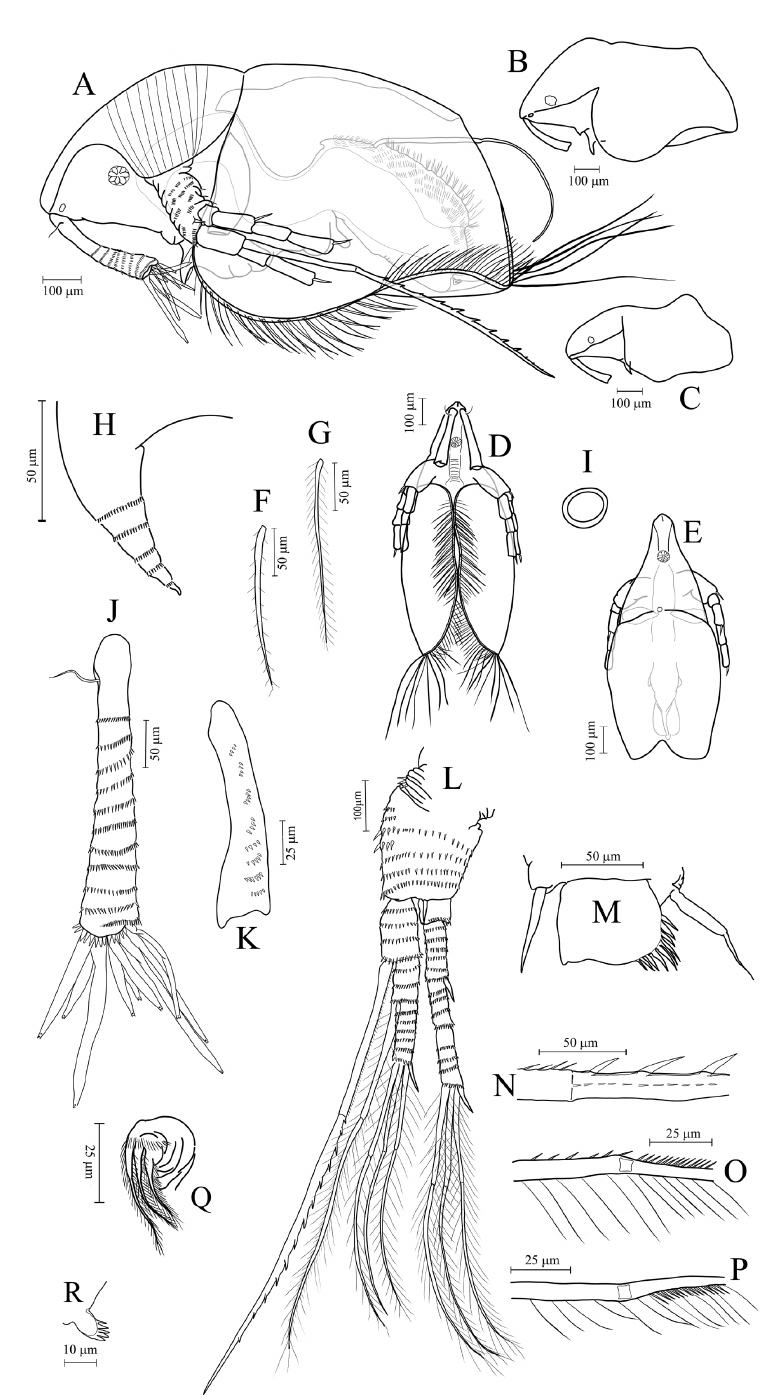
Fig. 2. Acantholeberis accolismaris Sousa, Elmoor-Loureiro & Álvarez-Silva sp. nov., parthenogenetic female from the Planície Costeira, Rio Grande do Sul (FDRS0696). A . Habitus, holotype. B–C . Lateral view, shape variation of carapace. D . Ventral view. E . Dorsal view. F . Outwardly directed setae. G . Plumose and ventrally directed setae. H . Horn-like outgrowth anterior to labrum. I . Dorsal organ. J . Antennule. K . Idem, inner surface. L . Antenna. M . Idem, first segment of exopodite, distal outer spine and inner sensory seta on basal segment. N . Idem, lateral seta of first segment of endopodite, armature detail. O–P . Morphology of apical setae of endopodite and exopodite. Q . Maxilla. R . Idem, short